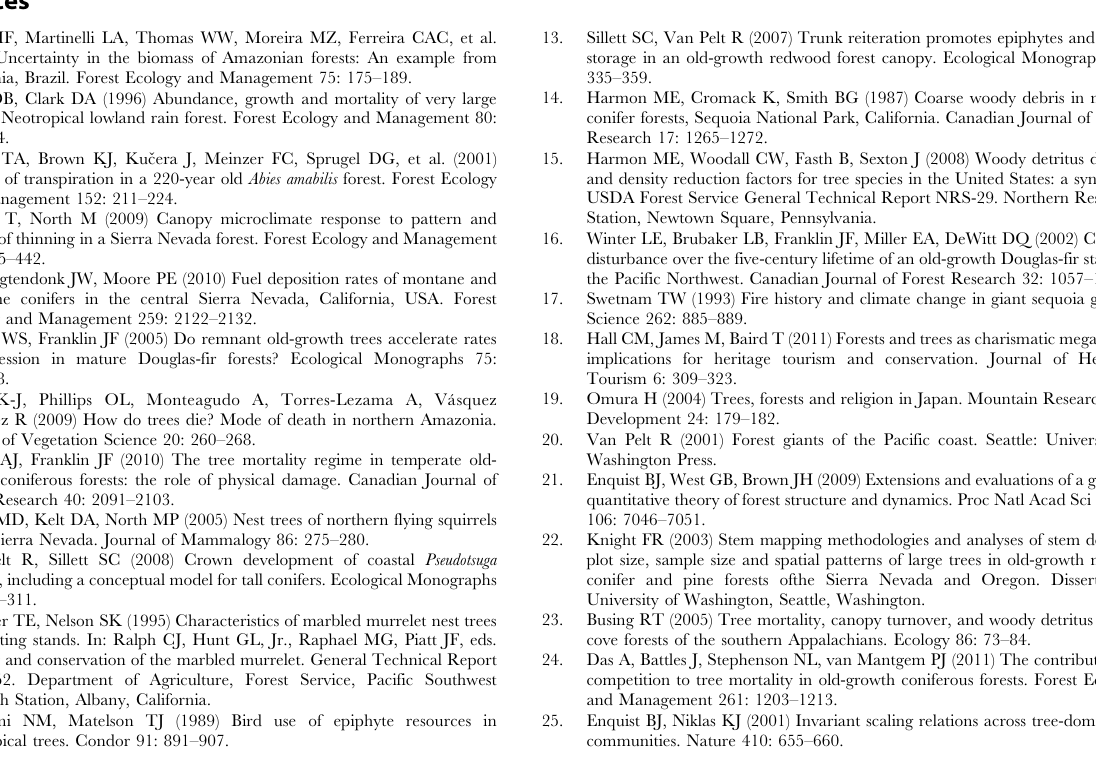
Figure S1 Topography of the Yosemite Forest Dynamics Plot. LiDAR-derived ground model at 1 m resolution (5 m contours; 137.2 m vertical relief). Dots indicate corners of each 20 m 6 20 m quadrat of the 800 m 6 320 m plot. Elevation ranges from 1774.1 m in the northeast corner to 1911.3 m along the southern boundary for a vertical relief of 137.2 m. Drainages contain vernal streams. Figure S2 Climatology and water balance of the Yose- mite Forest Dynamics Plot. The combination of temperature and precipitation (A) give rise to a pronounced summer